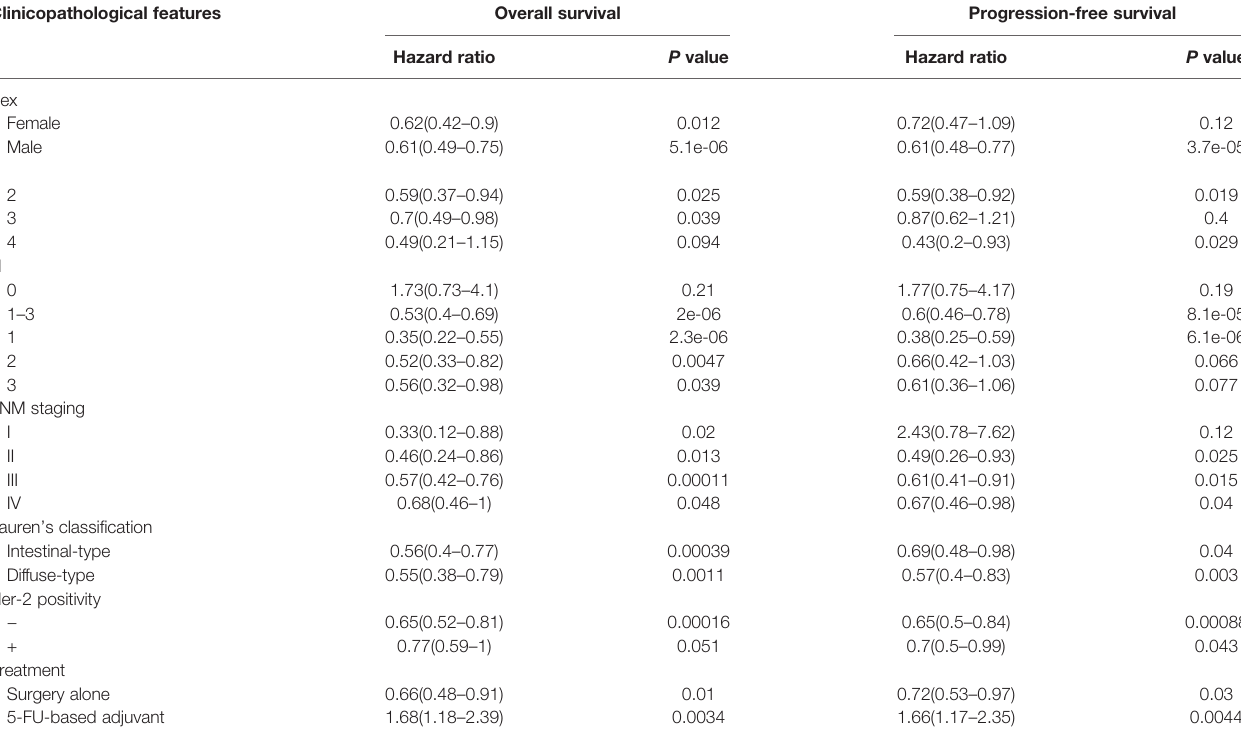
TABLE 3 | The prognostic signi fi cance of Becn1 mRNA in gastric cancer by Kaplan – Meier plotter. Clinicopathological